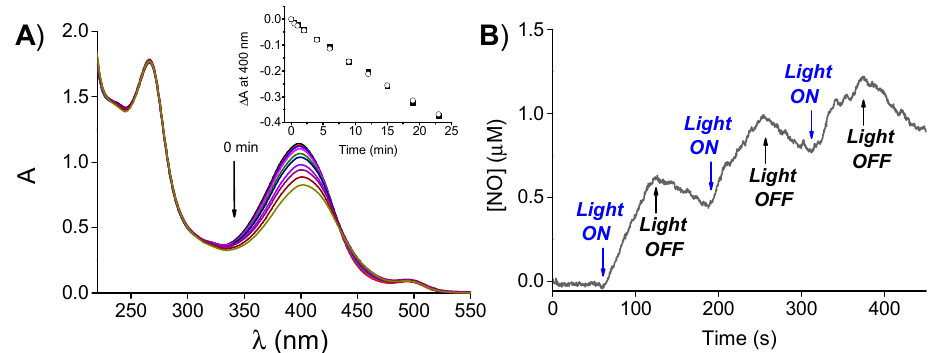
Figure 3. ( A ) Absorption spectral changes observed upon 405-nm light irradiation of an aqueous solution of PolyCDNO (1 mg mL − 1 ) encapsulating SRB (18 μ g mL − 1 ). The inset shows the absorbance changes at 400 nm of PolyCDNO in the presence ( ) and, for comparison, in the absence ( ) of SRB. ( B ) NO release profile observed for PolyCDNO (1 mg mL − 1 ) in the presence of SRB (18 μ g mL − 1 ). Photo-regulated NO release from the PolyCDNO/SRB complex was demonstrated by direct detection by using amperometric techniques. As illustrated in Figure 3B, NO photorelease from the complex occurred only upon light stimuli with a quantum efficiency Φ NO = 0.006 ± 0.001, very similar to that previously reported for the free polymer ( Φ NO = 0.005 ± 0.001) [39] and in excellent agreement with the photobleaching experiments of Figure 4A.